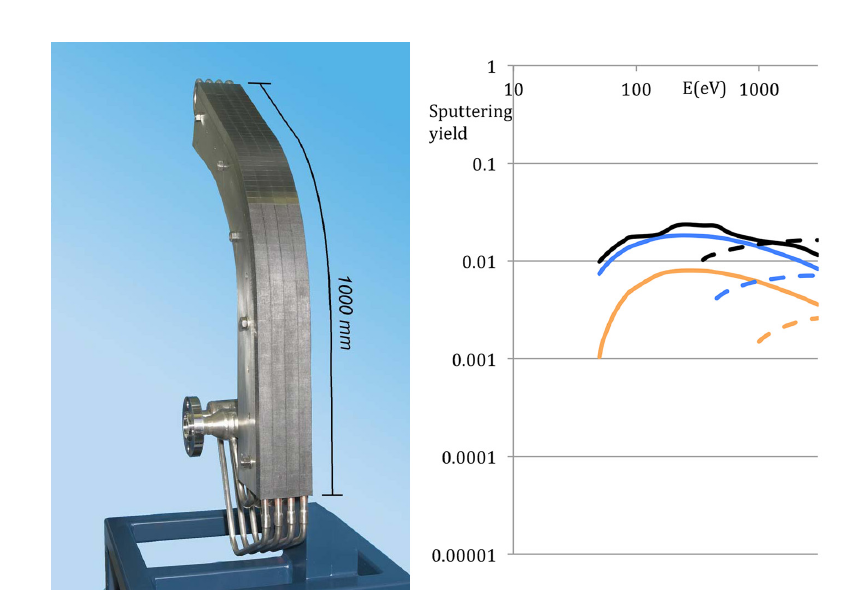
Fig. 4. – Tungsten monoblock mock up (courtesy EUROfusion) and physical sputtering yield vs. incident ion energy for tungsten (dashed lines) and carbon (continuous lines) under the bombardment by tritium (black), deuterium (blue) and hydrogen